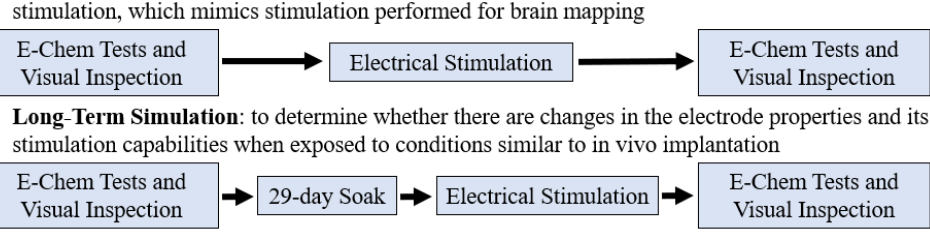
Figure 2. Schematic of testing paradigms. E-Chem tests consisted of EIS, CV, and